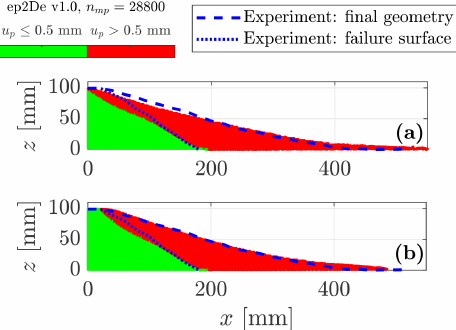
Figure C1. (a) Numerical solution without any volumetric locking strategy and (b) numerical solution with the proposed volumetric locking strategy. For both cases, no damping is